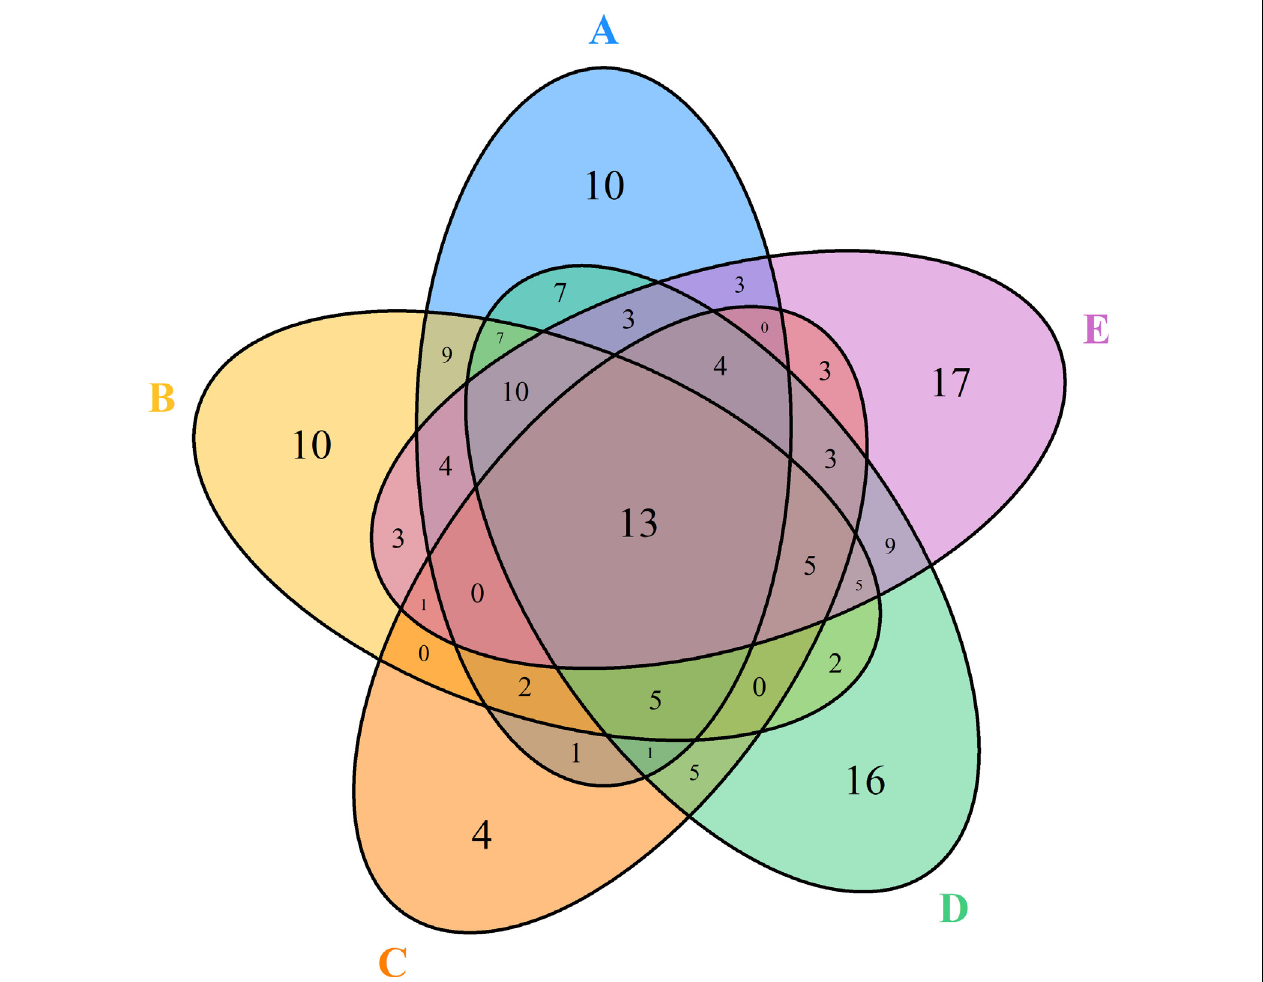
FIGURE 6 | Degree of overlap of the species composition in the five communities. A, B, C, D, and E were the Quercus variabilis community, Quercus glandulifera var. brevipetiolata community, Mixed broadleaf-conifer community, Quercus aliena var. acutiserrata community, and Miscellaneous wood community,